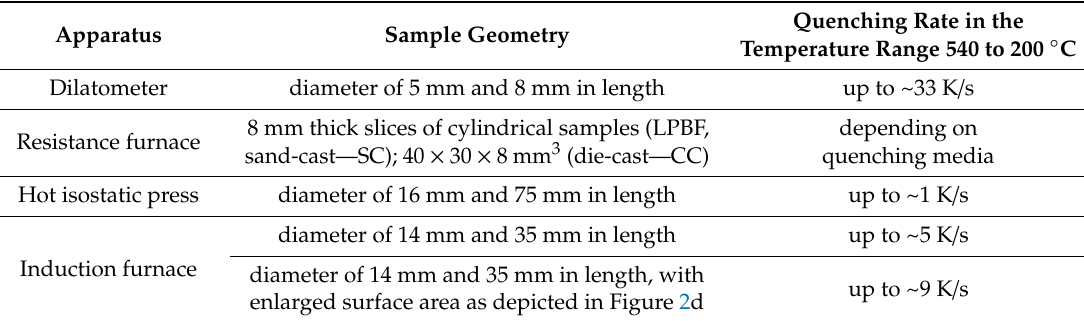
Table 3. Summary of the machined sample geometries for di ff erent heat treatment